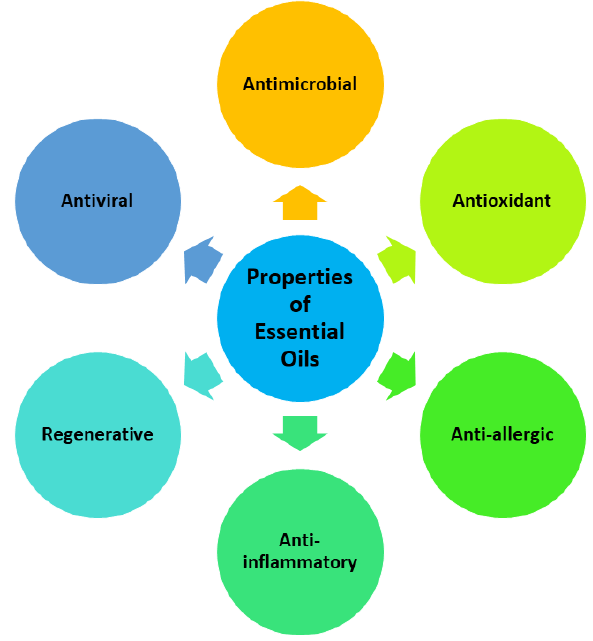
Figure 1. Biomedical properties of essential oils.